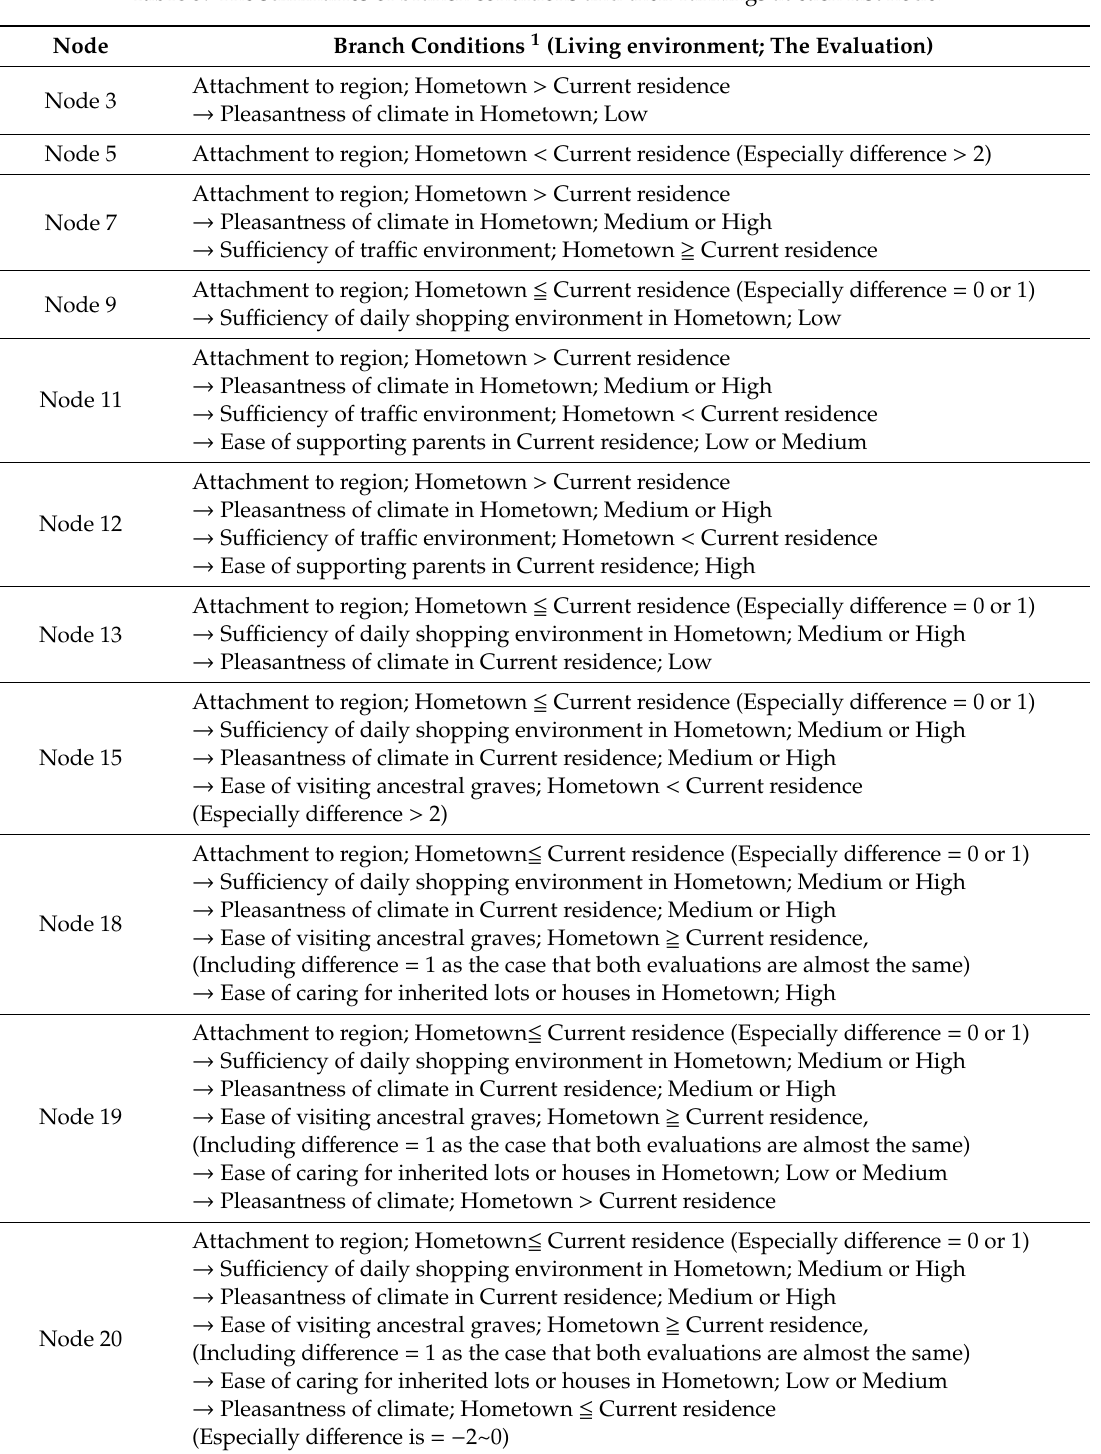
Table 5. The summaries of branch conditions and their rankings at each last